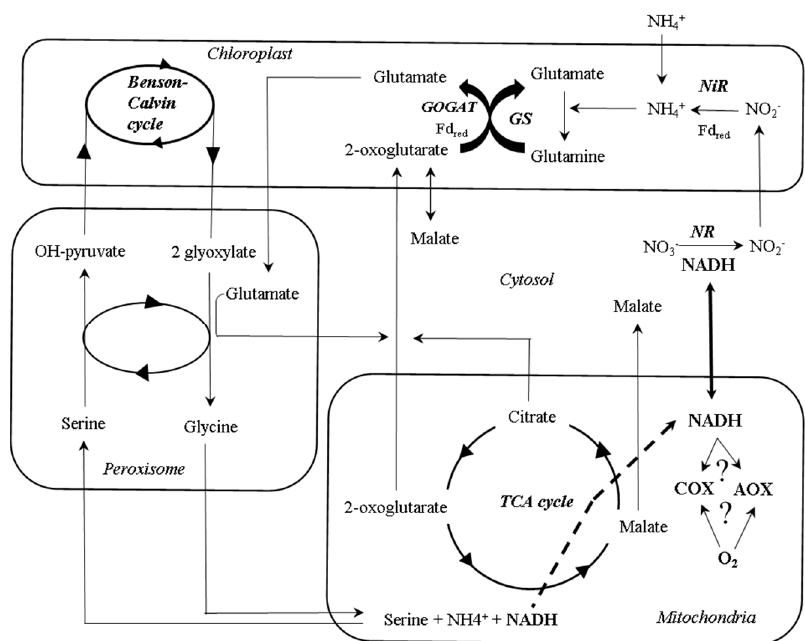
Figure 3. A simplified schematic overview of the compartmentation of some of the interactions between primary metabolism pathways during ammonium and nitrate assimilation. Nitrate is mainly transported from roots to leaves via xylem, where it is converted into nitrite with the consumption of reducing equivalents in cytosol. In the chloroplast, the reducing power of light-activated electrons drives the conversion of nitrite to ammonium from cytosolic nitrate reductase (NR)-derived nitrite by a nitrite reductase (NiR) activity, and its assimilation by the GS / GOGAT cycle. 2-oxoglutarate which is required for ammonium assimilation, is exported to the chloroplast by a 2-oxoglutarate / malate translocator. Ammonium uptake bypasses the nitrate reductase reaction in cytosol, thus increasing the reducing equivalents available that can be dissipated during respiration. During photorespiration, the retrieval of CO 2 and NH 4 + during the glycine cleavage reaction in mitochondria leads to an increased NADH / NAD + ratio in the mitochondrial matrix that has been suggested to be related to changes in AOX activity. TCA, tricarboxylic acid.